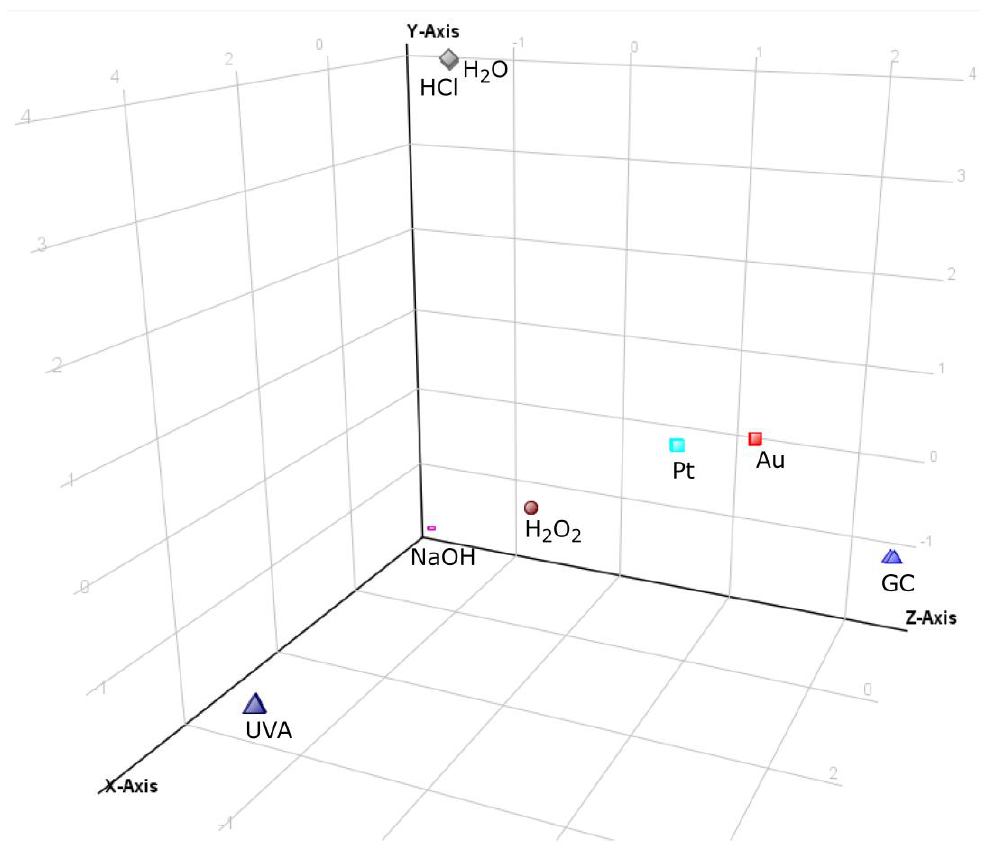
Figure 1. The 3D PCA plot of forced degradation profiles of maraviroc in tested conditions.